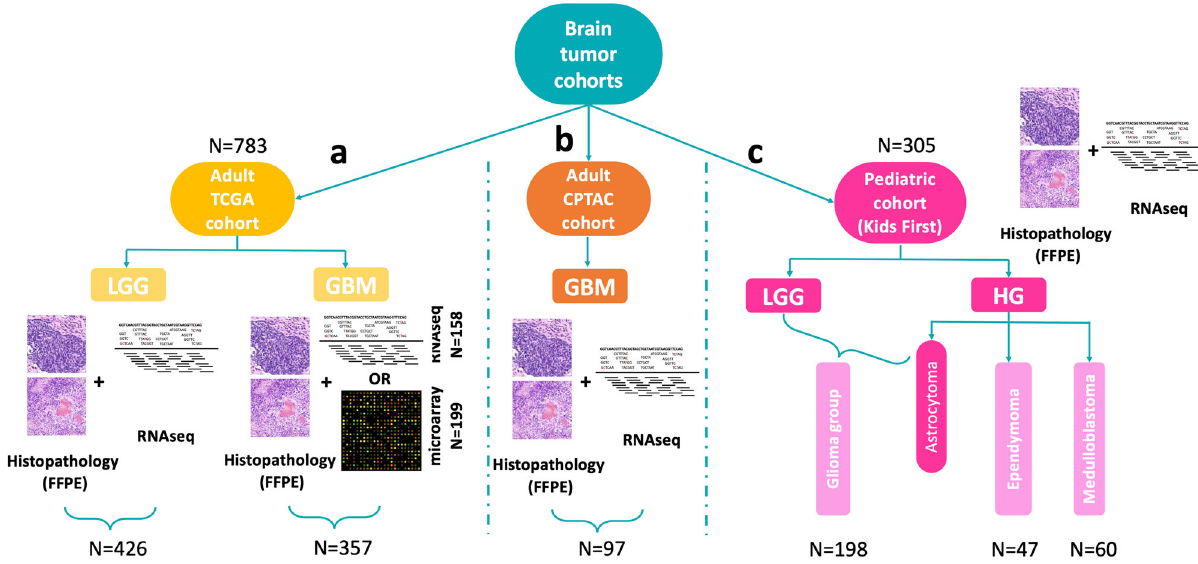
Fig. 1 Overview of used datasets and samples. a Adult brain tumor The Cancer Genome Atlas (TCGA) cohort ( N = 783) consisting of both low-grade glioma (LGG) ( N = 426) and glioblastoma (GBM) (357) samples. For the LGG samples, both histopathology images and RNA-sequencing data were available. While histopathology images were available for all GBM samples, 158 of these had RNA-sequencing, and 199 microarray expression data. b Adult Clinical Proteomic Tumor Analysis Consortium (CPTAC)-GBM cohort with histopathology and RNA-sequencing data ( N = 97). c Pediatric Brain Tumor Atlas (PBTA) Kids First cohort ( N = 305). This cohorts consists of four tumor subtypes: LGG and high-grade (HG) astrocytoma (combined in one Glioma group, N = 198), ependymoma ( N = 47), and Medulloblastoma ( N = 60). Both histopathology images and RNA-sequencing data were available for all samples of this pediatric